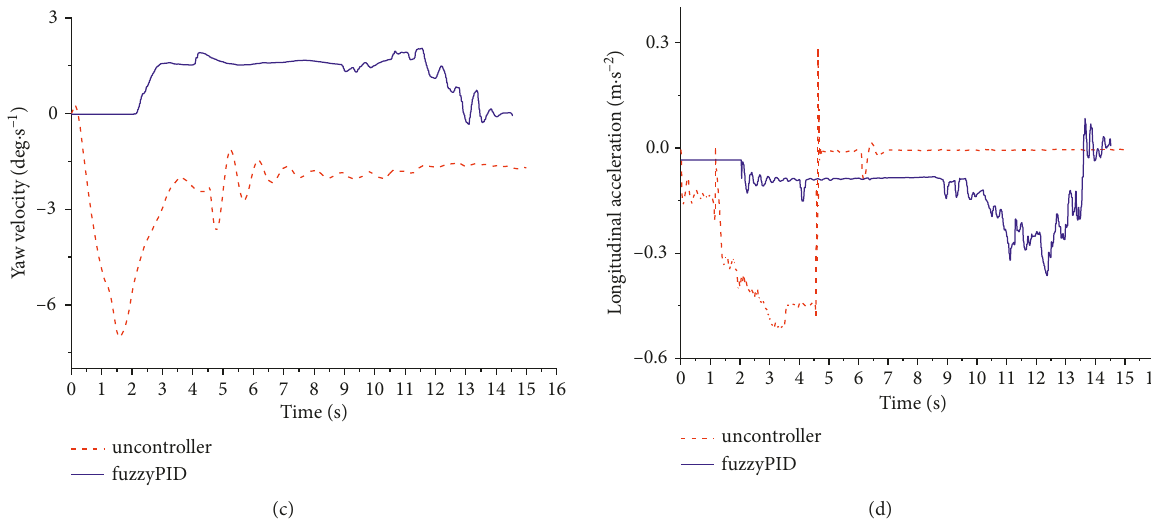
Figure 32: HIL test diagram under curve operating conditions when u � 0.5. (a) Braking distance. (b) Lateral acceleration. (c) Yaw velocity. (d) Longitudinal acceleration.